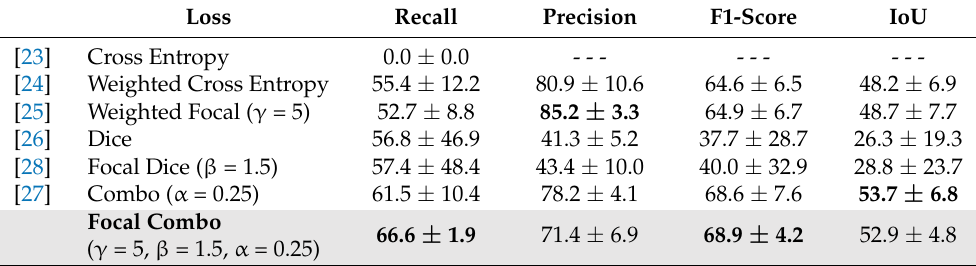
Table 5. Results after the ‘black’ pixel omission for fast-SCNN in (%) for the road marking class. Loss